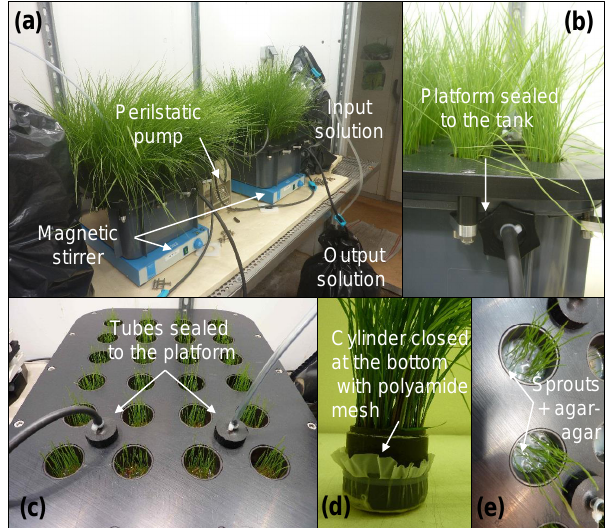
Figure 1. The labeling experiment in the growth chamber. (a) The two labeled tanks are connected to the solution containers. A peri- staltic pump facilitates the solution renewals. (b) A platform is sealed to each tank. (c) Plant-receiving pots are cylinders closed at the bottom with a polyamide mesh. (d) Twenty-four plant-receiving pots are inserted into each platform. (e) In each pot, agar-agar was added around the sprouts to limit gas